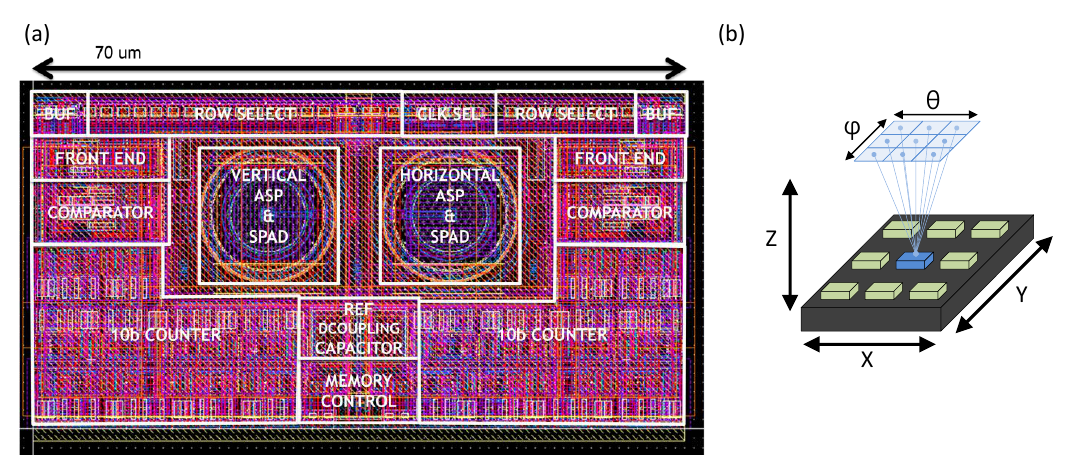
Figure 6. ( a ) Layout of two ( θ and φ sensitive) A-SPAD pixels. ( b ) illustration of θ and φ